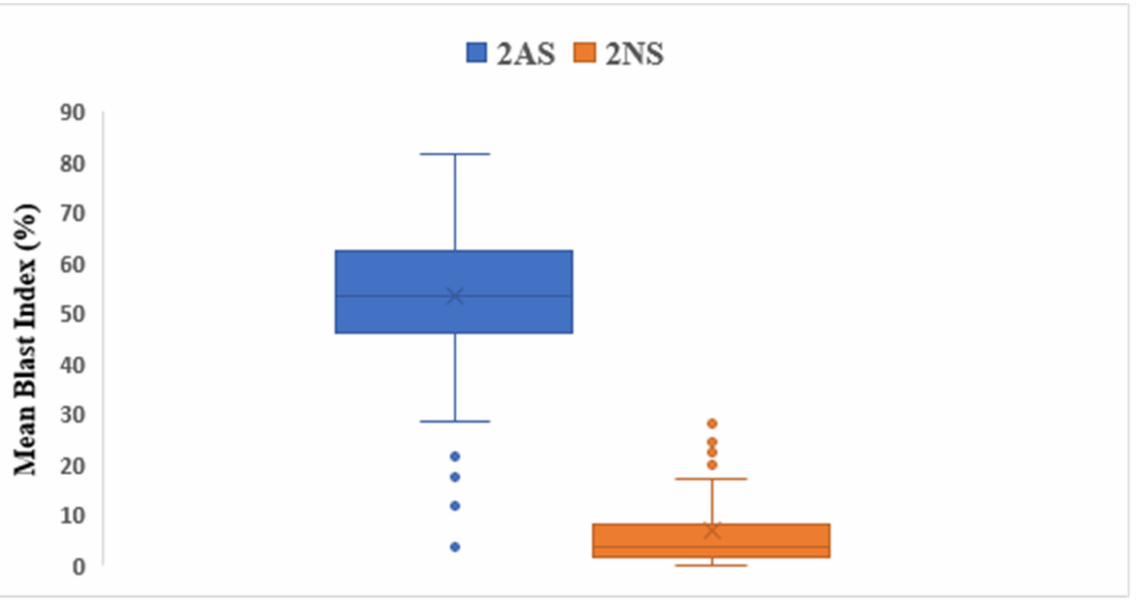
Figure 3. Effects of the 2AS and 2NS segments on grand mean blast